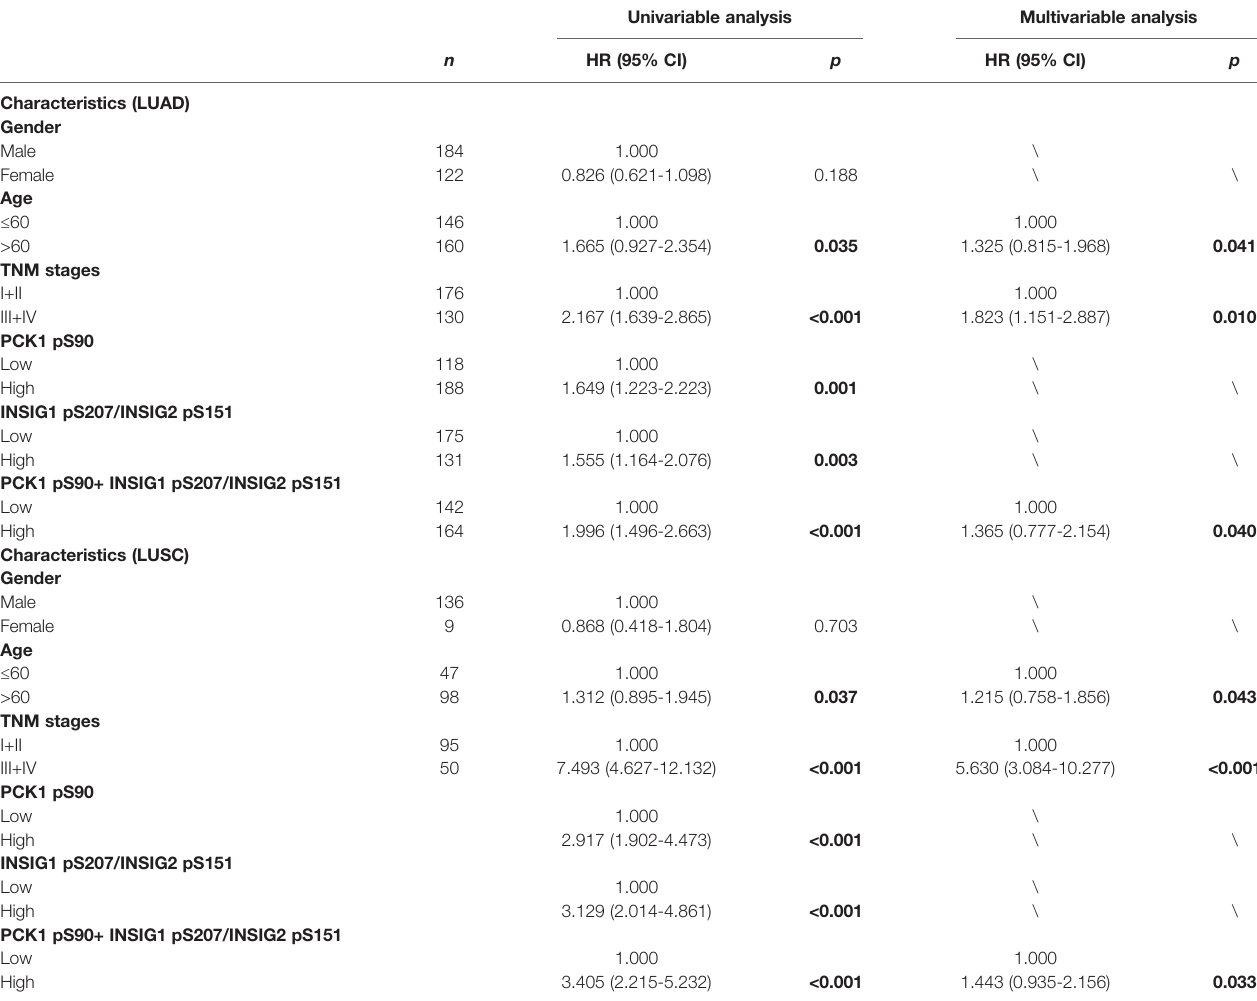
TABLE 2 | Univariable and multivariable overall survival analysis in patients with LUAD and